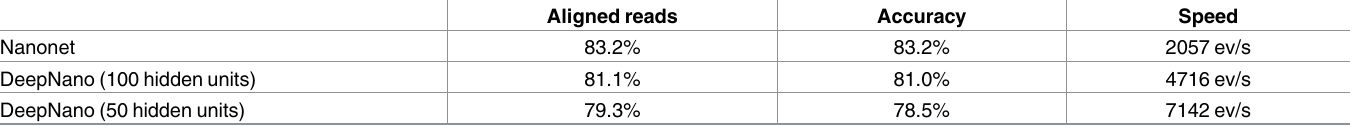
Table 3. Accuracyand running time on R9 data. The results of base callingwere alignedto the reference using BWA-MEM [28]. The first column reports the percentage of reads that alignedto the reference on at least 90% of their length. The accuracy was computed as the numberof matches in the alignment dividedby the length of the alignment.The speed is measuredin events per